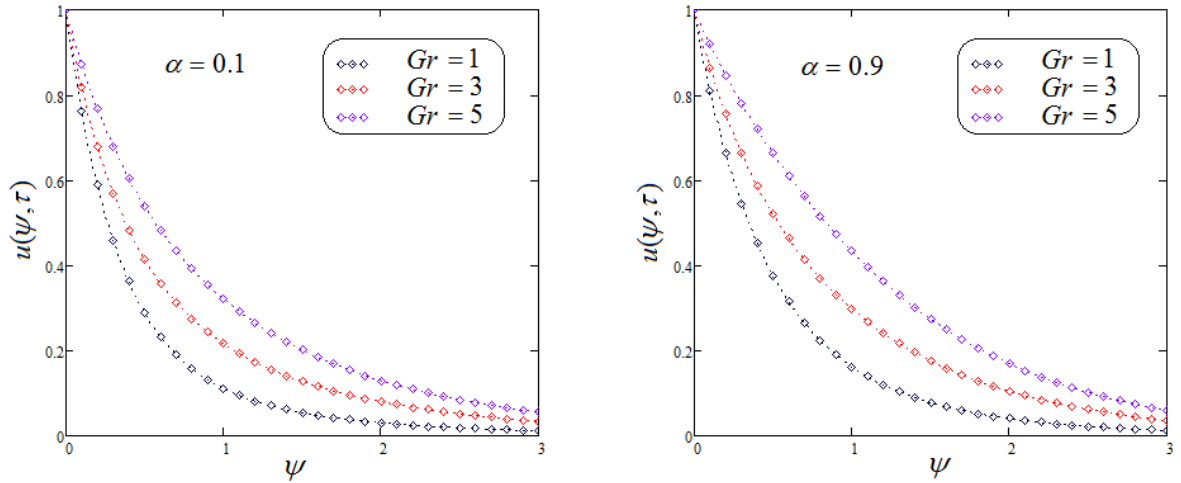
Figure 5. Trace of velocity for dissimilar values of Gr